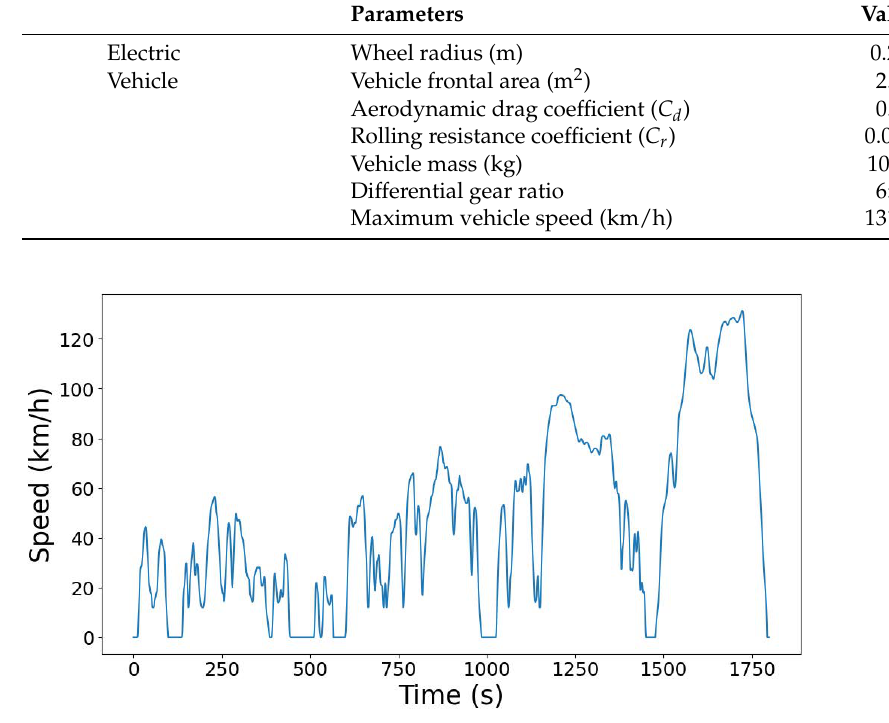
Figure 2. Motor speed over the WLTP